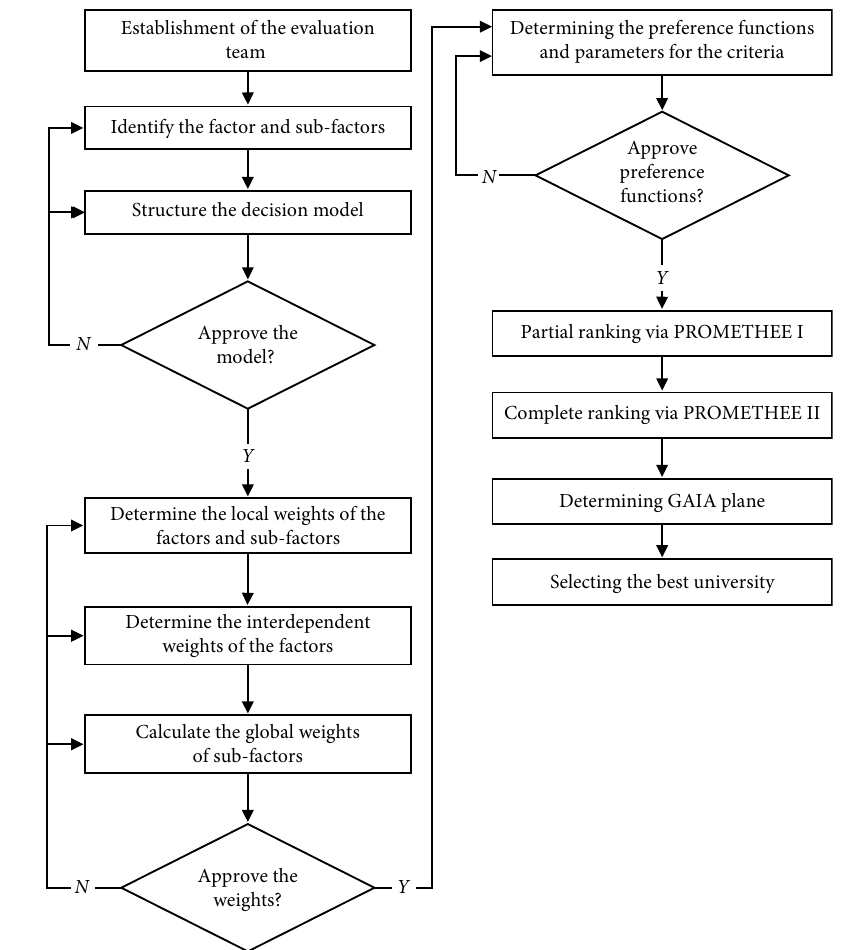
Fig. 1. The flowchart of the proposed model for university